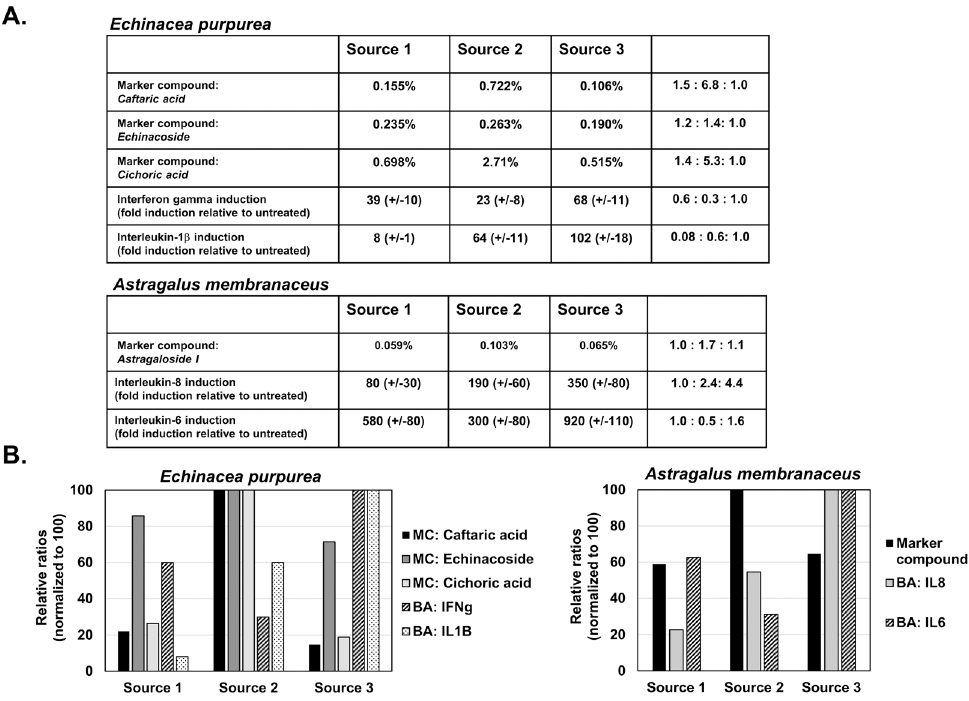
Fig 4. Marker compound level and bioactivity of immune-stimulatory herbs. Part A) Marker compound level (percent of total weight) of cafteric acid, echinacoside and cichoric acid (from E . purpurea) and astragaloside I (from A . membranaceus) and cytokine induction values (relative to untreated) are shown from three commercial sources. Part B) Marker compound ratios and bioactivity ratios were normalized to 100 (max. level) and